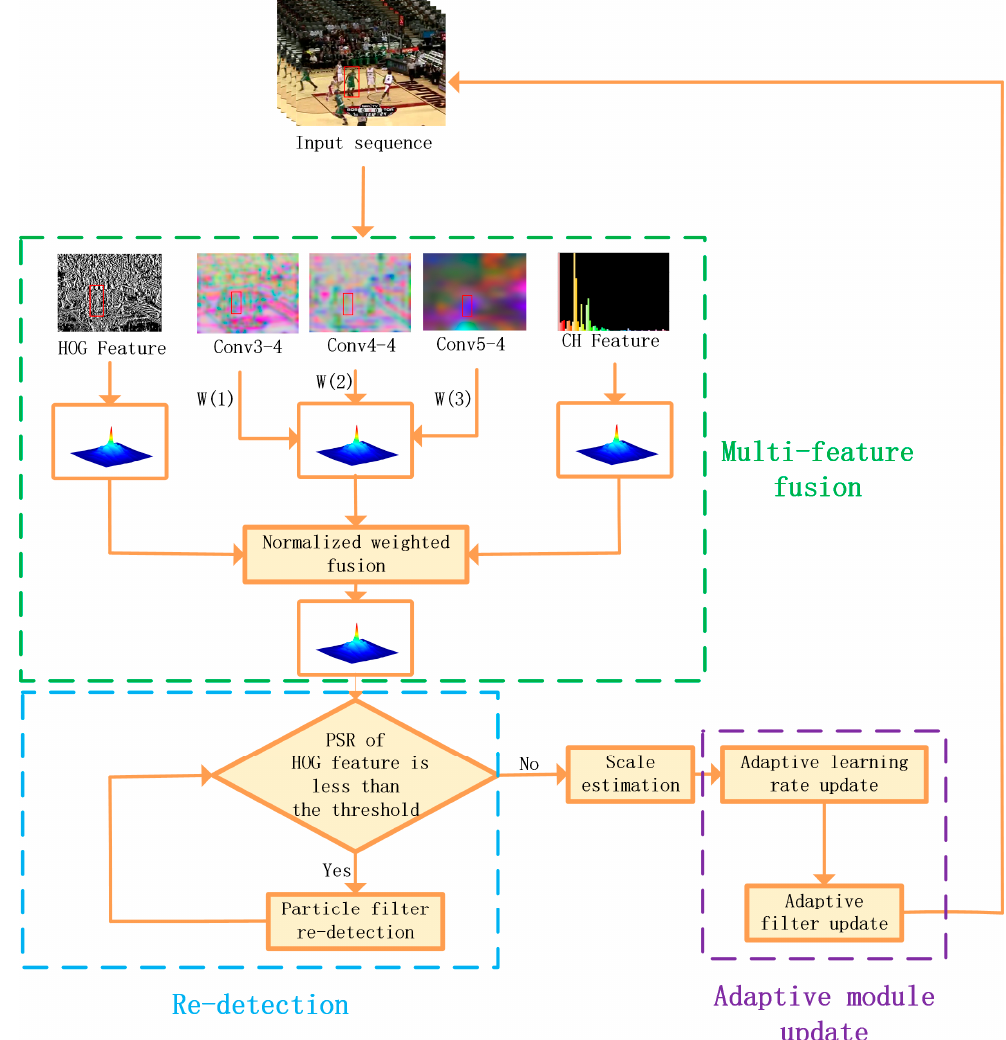
Figure 2. Framework diagram of the algorithm MFPF in this paper.